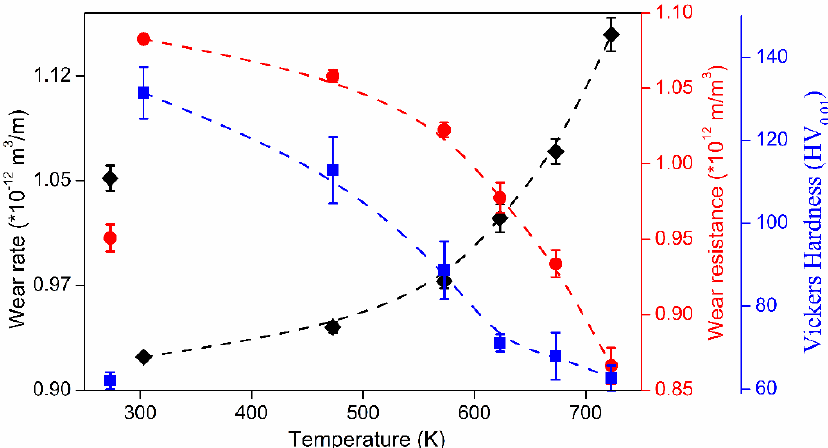
Figure 67. Sliding wear rate, wear volume and the Vickers hardness (HV) for Al-12Si cast, as-prepared SLM (300 K) and SLM samples annealed at different temperatures [205]. Copyright 2014. Adapted with permission from Cambridge University Press under the license number 4605401109358 (Figure 2 [205]), dated 24 May 2019.